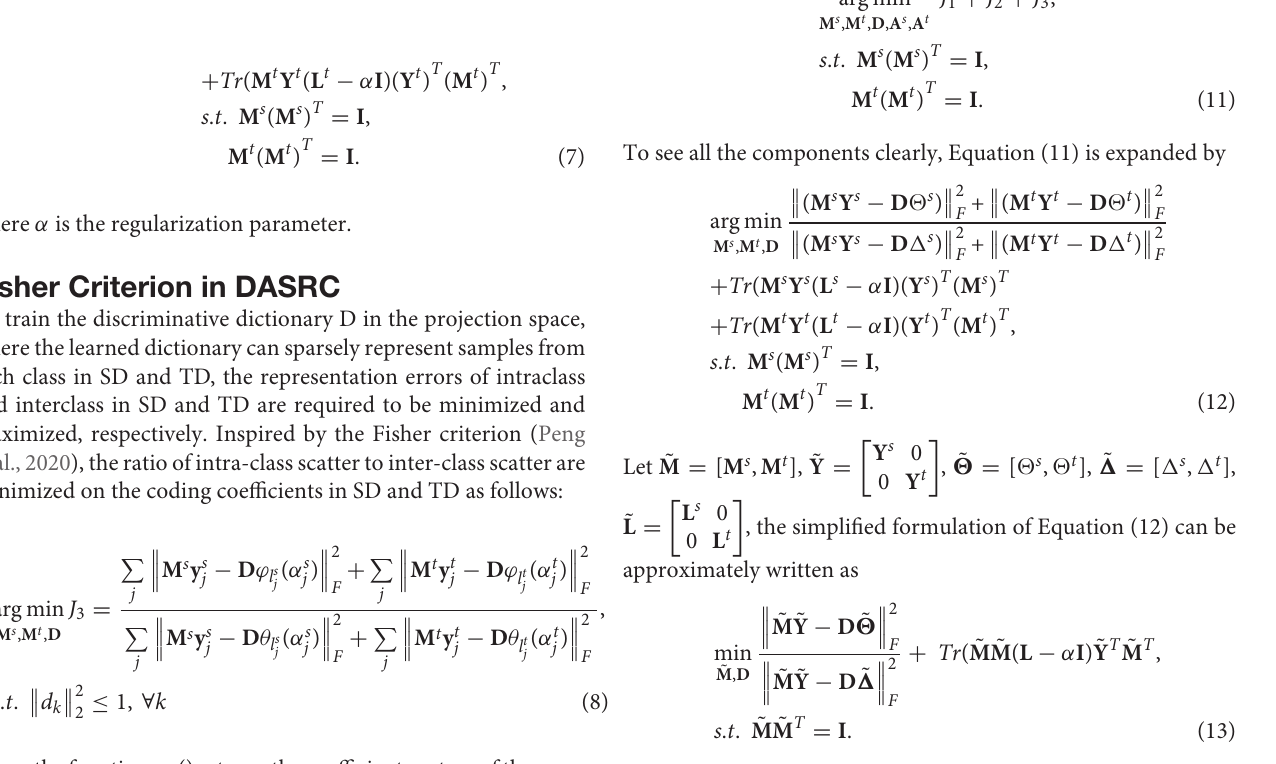
The bold values in Tables 2 , 3 mean the best values in comparison